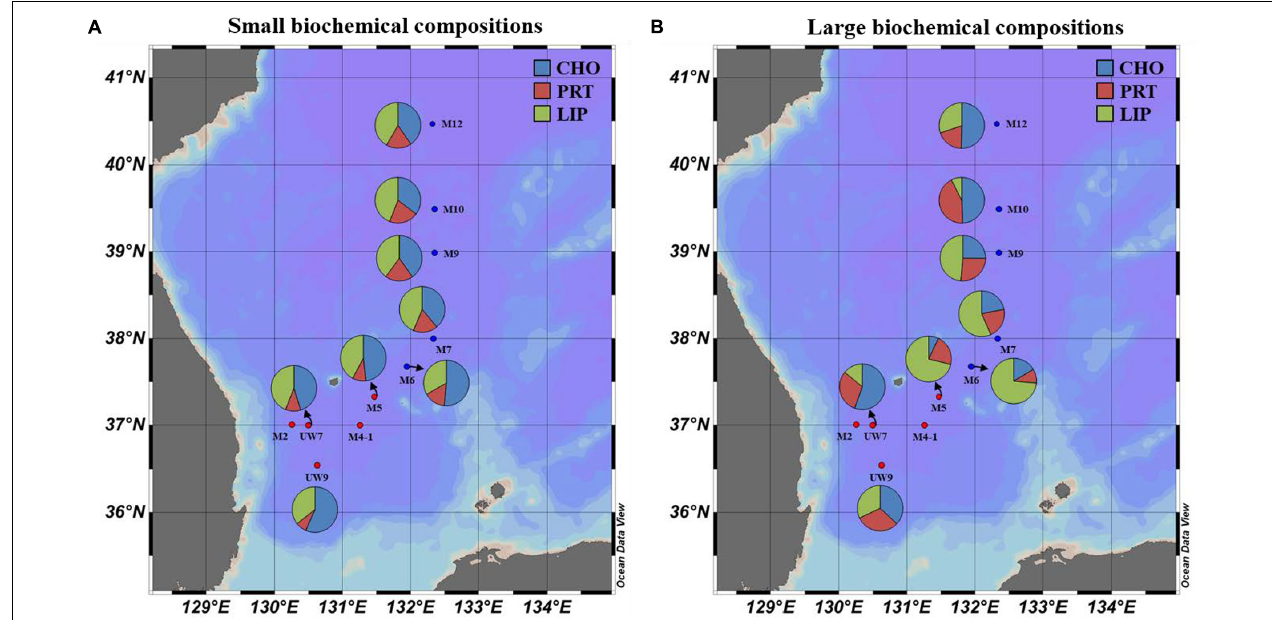
FIGURE 8 | Spatial distributions of biochemical compositions (carbohydrates, proteins, and lipids) for (A) small and (B) large size phytoplankton in the western EJS in 2016. CHO, carbohydrates; PRT, proteins; LIP,